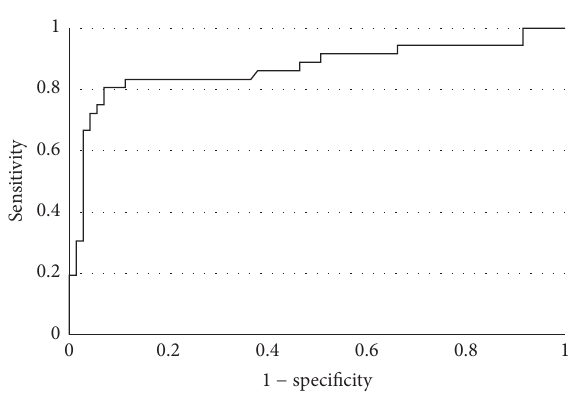
Figure 3: Receiver operating characteristic (ROC) for fecal calpro- tectin